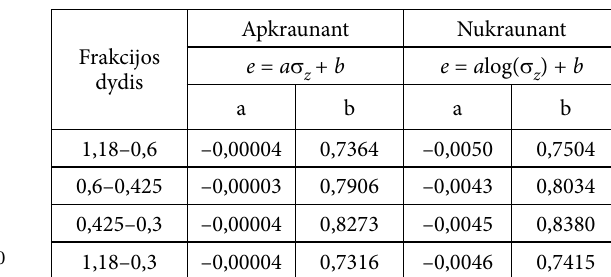
Table 1. Function coefficients of void ratio versus load